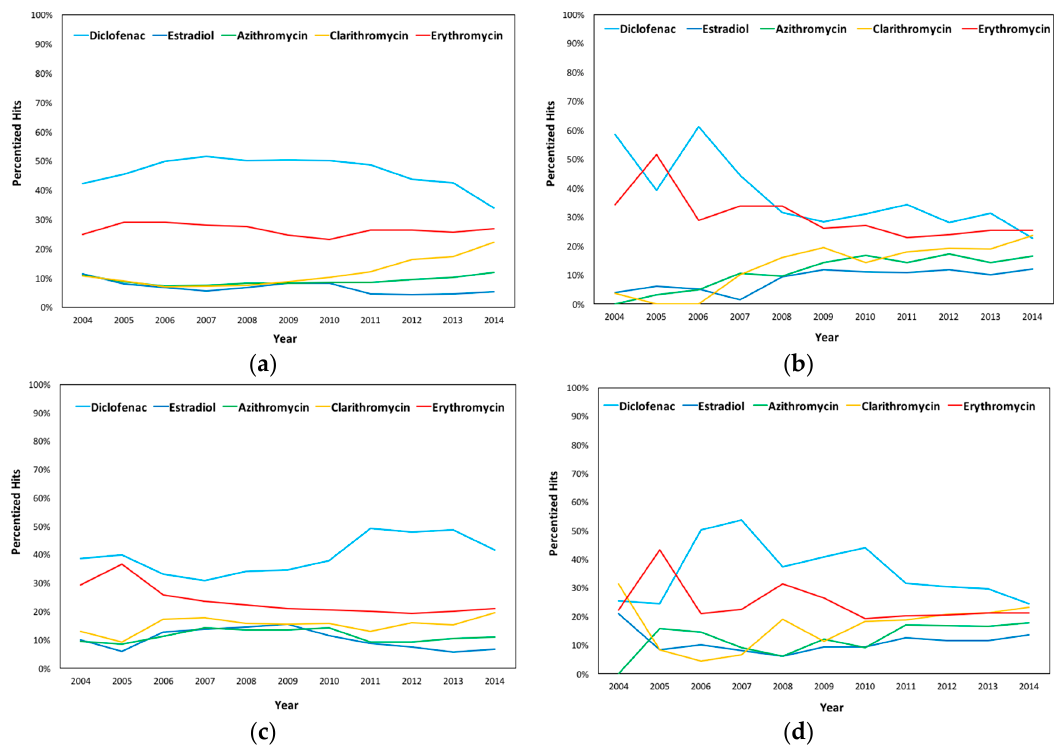
Figure 2. Yearly Averages of the Percentized Hits in ( a ) England; ( b ) Wales; ( c ) Scotland; and ( d ) Northern Ireland in Diclofenac, Estradiol, Azithromycin, Clarithromycin, and Erythromycin from 2004 to 2014.